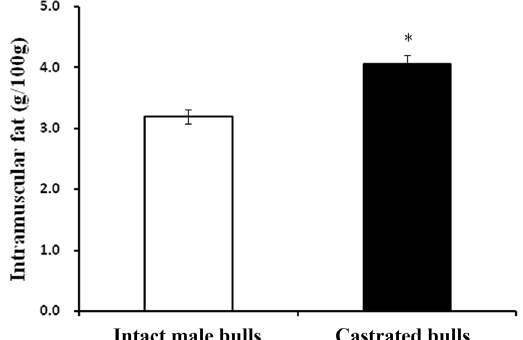
Figure 1. Effects of castration on bovine intramuscular fat content. Values are presented as the means ± S.E.M. “ * ”Represents significant differences P < 0.05.